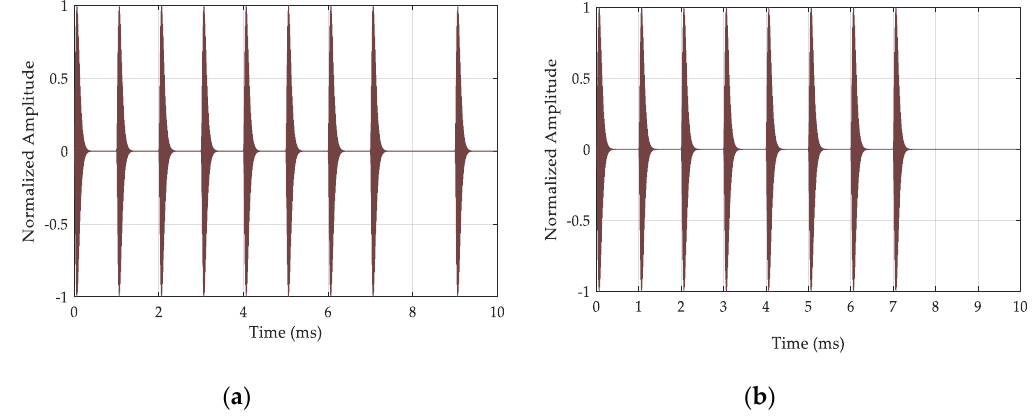
Figure 2. The characteristics of a Loran-C pulse group signal: ( a ) master station; ( b ) secondary station. Table 1. Phase codes of Loran-C signals.